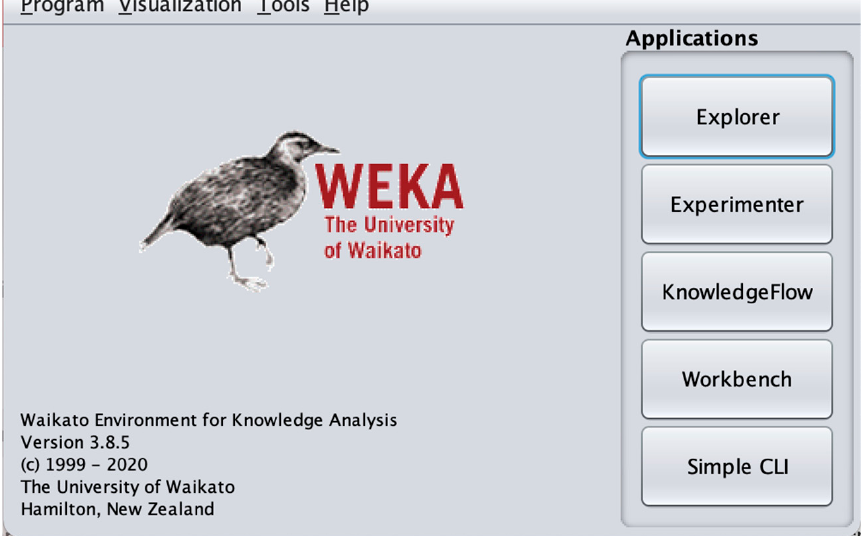
Figure 2. The main page of WEKA displaying the five modules including Explorer, Experimenter, Knowledge Flow, Workbench and Simple CLI.